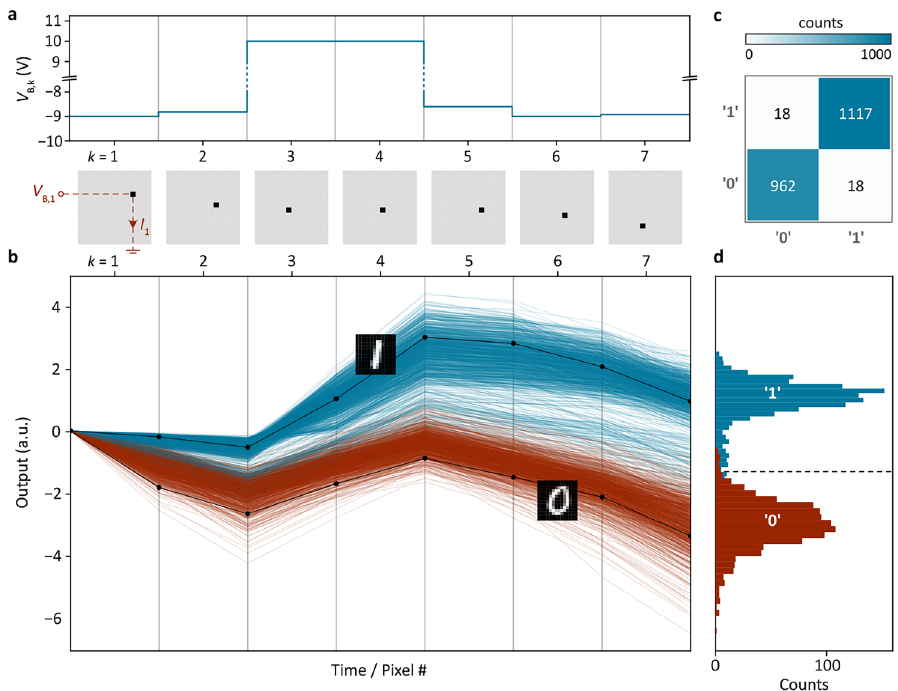
Figure 3. Image sensor operation and performance evaluation. ( a ) Relevant pixel locations k (bottom) and applied bias voltages V B,k (top) for the binary classification task discussed in the main text. ( b ) Temporal evolution of the sensor output for more than 2000 samples from the dataset. Red (blue) lines show cases in which a “0” (“1”) has been projected onto the sensor. The black lines show two representative examples with corresponding MNIST digits. ( c ) Experimental confusion matrix. A classification accuracy of 98.3% is achieved. ( d ) Histogram of sensor output as determined from the measurements in b. The dashed line indicates the decision